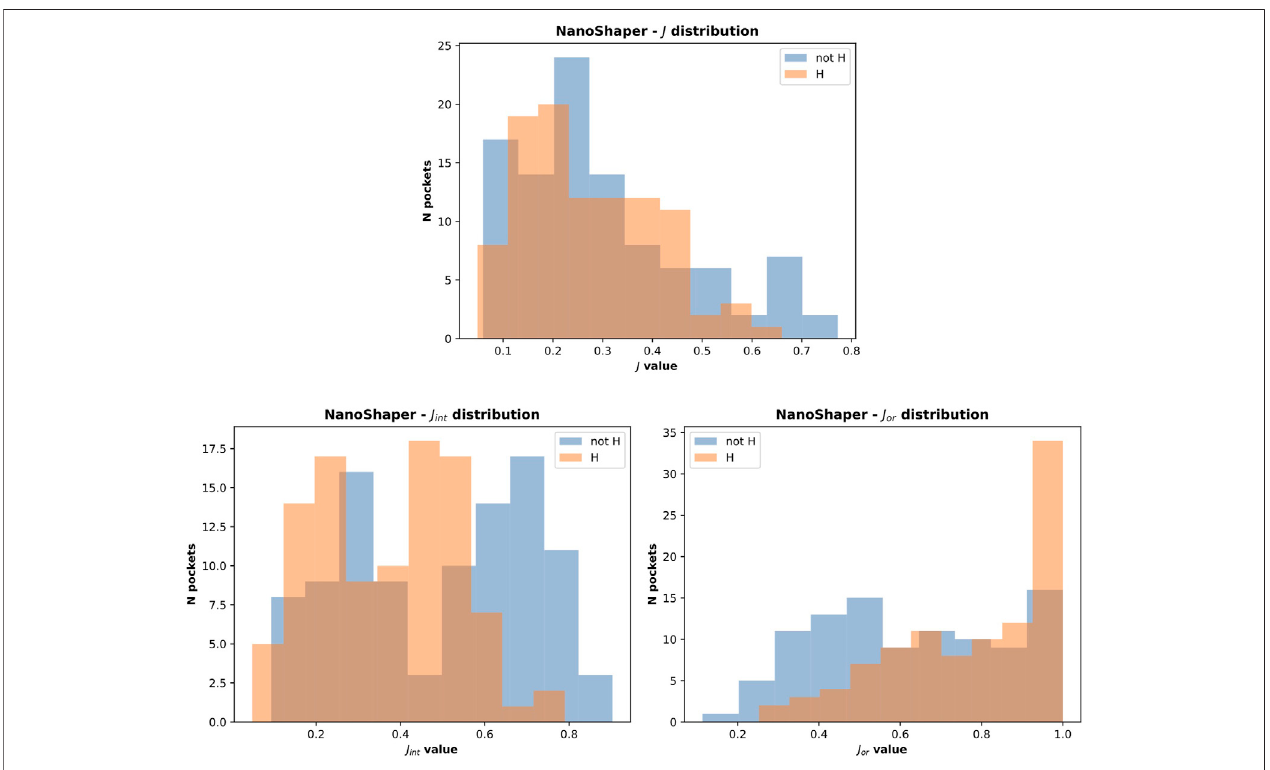
FIGURE 10 | NanoShaper score distribution with and without hydrogen atoms.